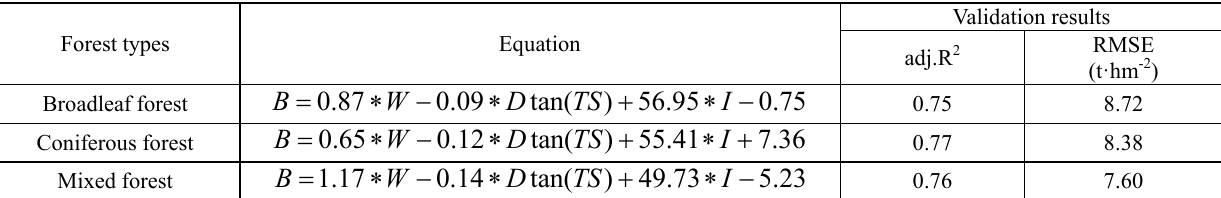
Table.4 Regression equations of AGB models of the three forest